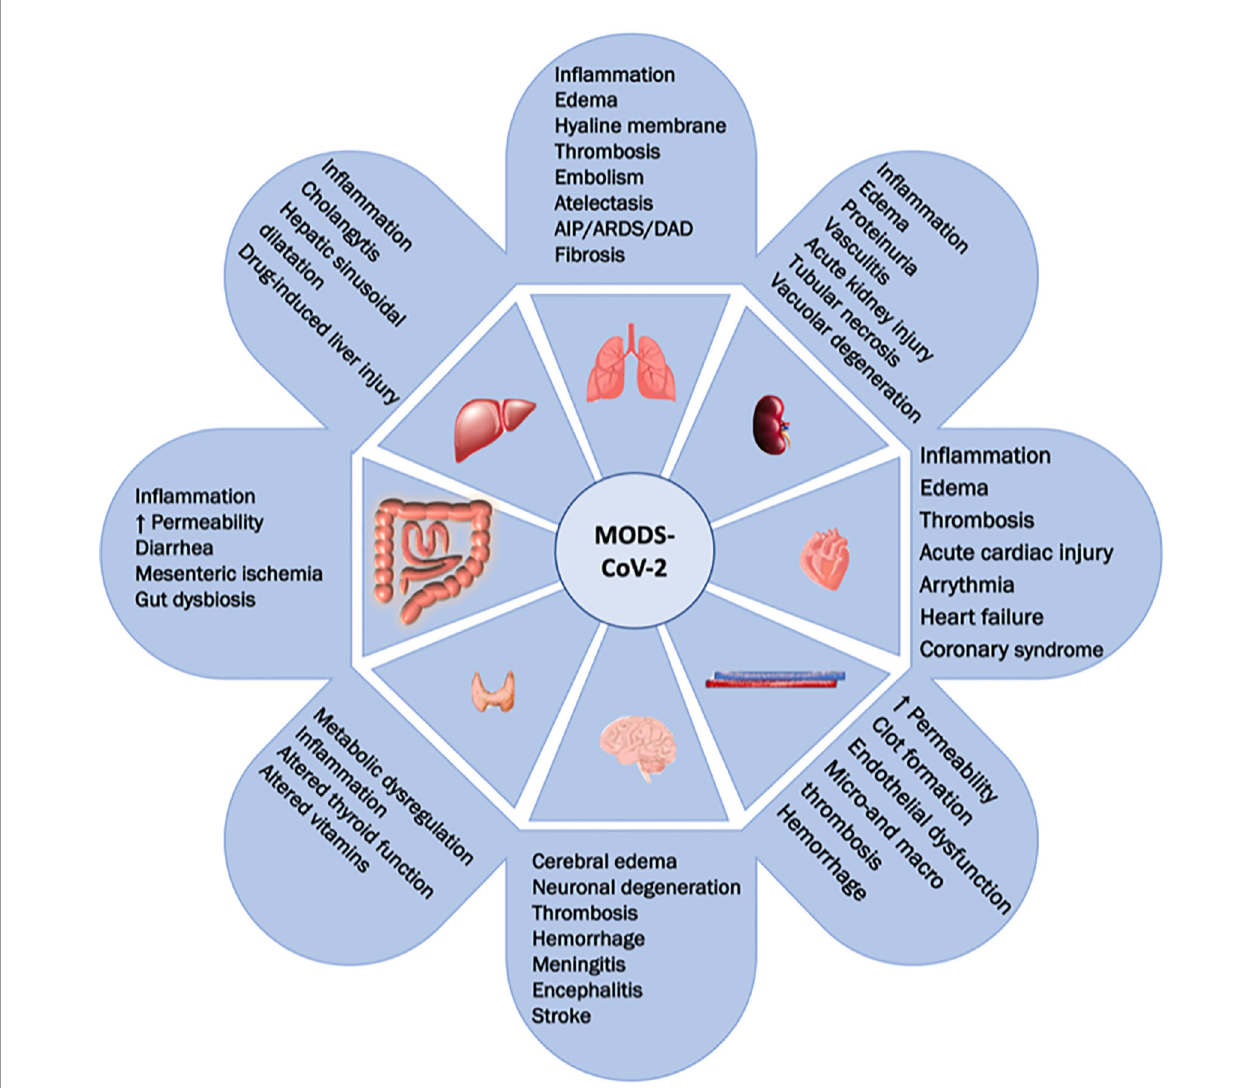
FIGURE 1 | COVID-19 multiple organ dysfunction. This fi gure shows the potential for multiorgan involvement in COVID-19. Respiratory (AIP, acute interstitial pneumonia; ARDS, acute respiratory distress syndrome; DAD, diffuse alveolar damage), renal, cardiovascular, coagulative/hemostatic, liver, gastrointestinal, metabolic/endocrine, and cerebral functions and systems, as well as their possible alterations, are